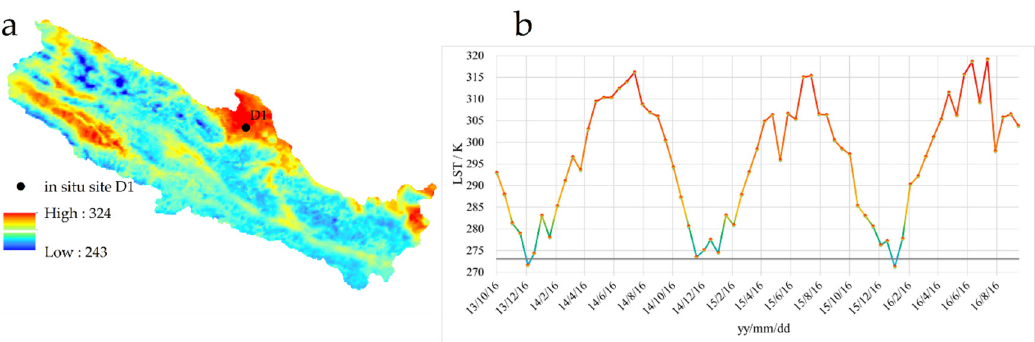
Figure 3. Land Surface Temperature (LST) data in the study area. ( a ) the LST distribution and the location of the in situ observation site D1; ( b ) the LST change at the site D1. The temperature is in Kelvin.